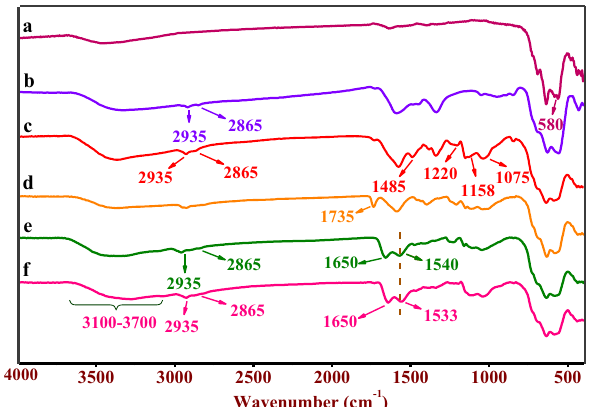
Figure 4. FT–IR spectra of the ( a ) γ–Fe 2 O 3 , ( b ) γ-Fe 2 O 3 @PEG, ( c ) γ-Fe 2 O 3 @PEG@APTES, ( d ) γ–Fe 2 O 3 @ PEG@MAc, ( e )